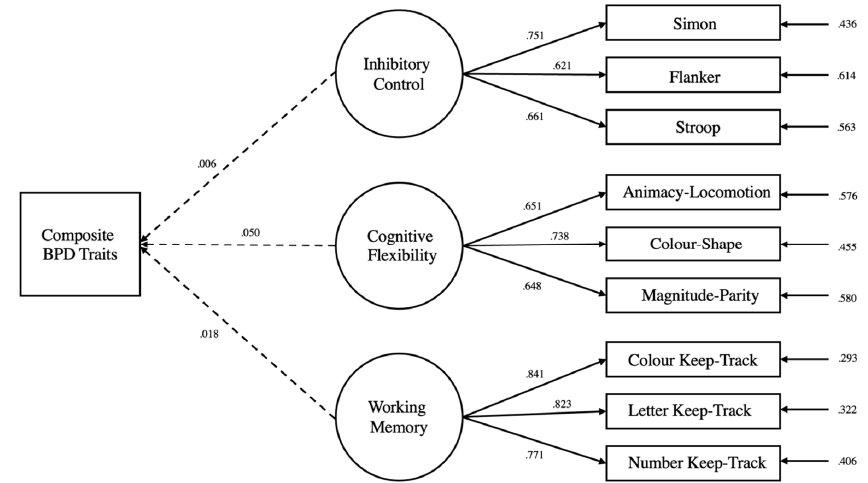
Figure 3. Structural equation model of the composite BPD regressed against three latent variable executive function. Circles represent latent variables while boxes represent manifest variables. Sin ‐ gle ‐ headed arrows connecting latent variables to manifest variables represent standardised factor loadings. Single ‐ headed arrows connecting executive function latent variables to the composite BPD traits represent regressions. Single ‐ headed arrows on the right of the figure represent error terms. The intercorrelations between the executive functions were modelled but not displayed in the fig ‐ ure. Solid lines represent significant relationships, while dashed line represents non ‐ significant re ‐ lationships, at the 0.05 level.